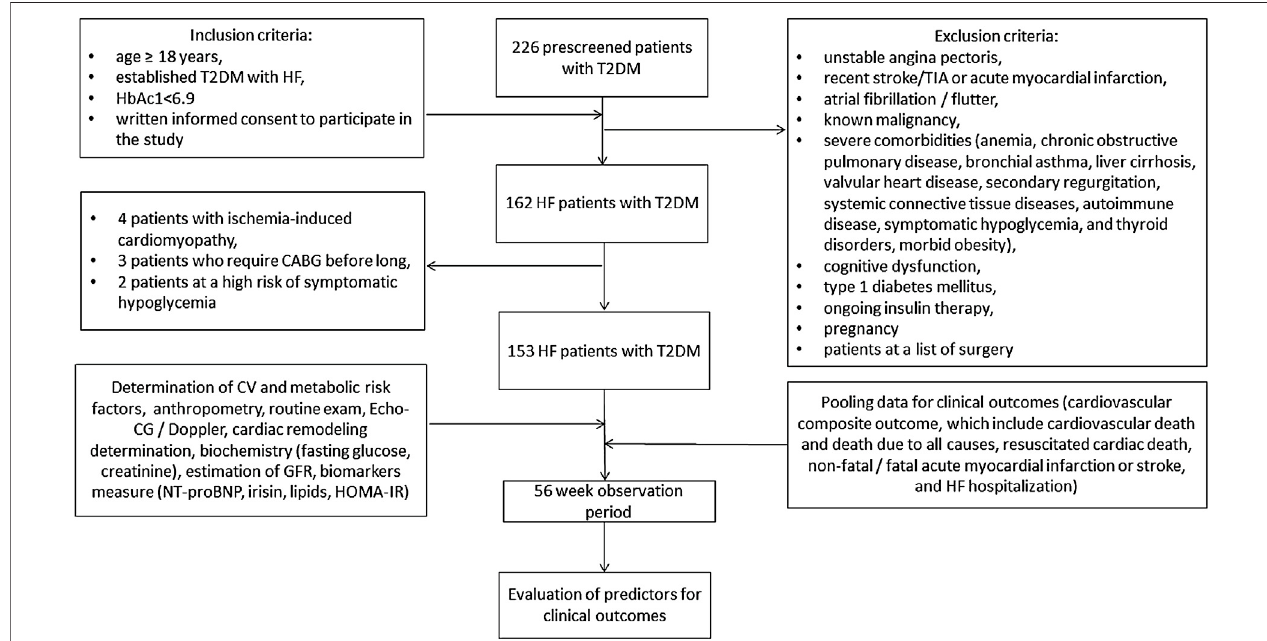
FIGURE 1 | Study design fl ow chart. Abbreviations: HF, heart failure; T2DM, type 2 diabetes mellitus; CABG, coronary artery bypass grafting; CV, cardiovascular; TIA,transientischemiaattack;Echo-CG,echocardiography; NT-proBNP,N-terminalfragmentofpro-natriureticpeptide;HOMA-IR,HomeostasisModelAssessmentof Insulin